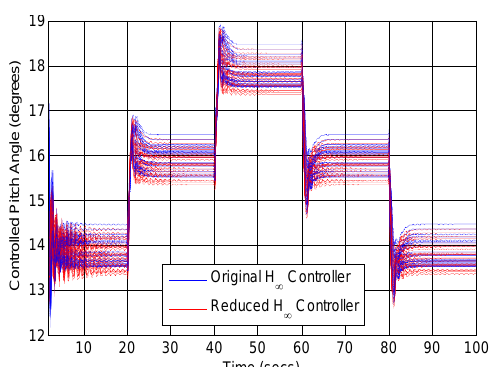
Figure 13. Controlled pitch angles (14 0 , 16 0 , 18 0 , 16 0 , 14 0 ) for uncertain models (10 samples) of wind turbine